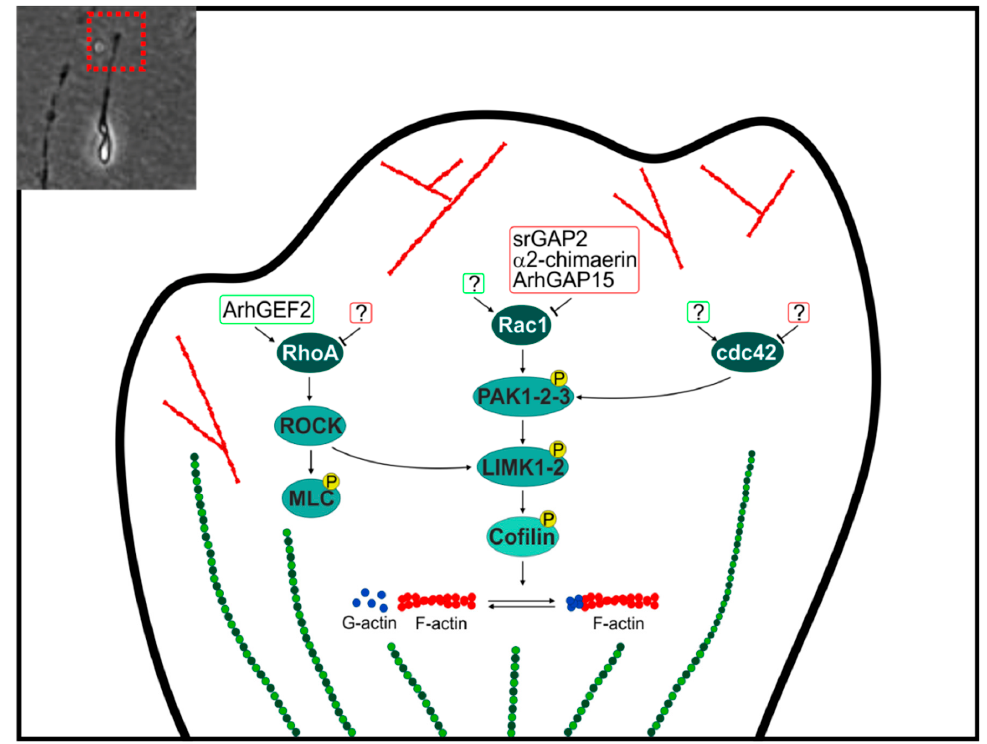
Figure 2. Regulations of Rho GTPases at the leading edge of a migrating neuron, by GAPs and GEFs implicated in Intellectual Disability. Green and red boxes surround GEF and GAP proteins, respectively. Circled P indicates phosphorylation. Arrows indicate activation, T bars indicate inhibition. A representative small magnification image of a migrating neuron with an evident leading edge is provided in the inset (top left). ROCK, Rho kinase-LIM domain kinase; MLC, myosin light chain; PAK1-2-3, p21-activated kinase 1-2-3; LIMK1-2, Rho kinase-LIM domain kinase 1-2. Homozygous frameshift mutations in the ARHGEF2 gene have been identified as cause of ID. The loss of normal ARHGEF2 activity leads to reduced activation of the RhoA-ROCK-MLC pathway, which in turn is crucial for cell migration. Indeed, ArhGEF2 − / − mice exhibit altered migration of precerebellar immature neurons [51].